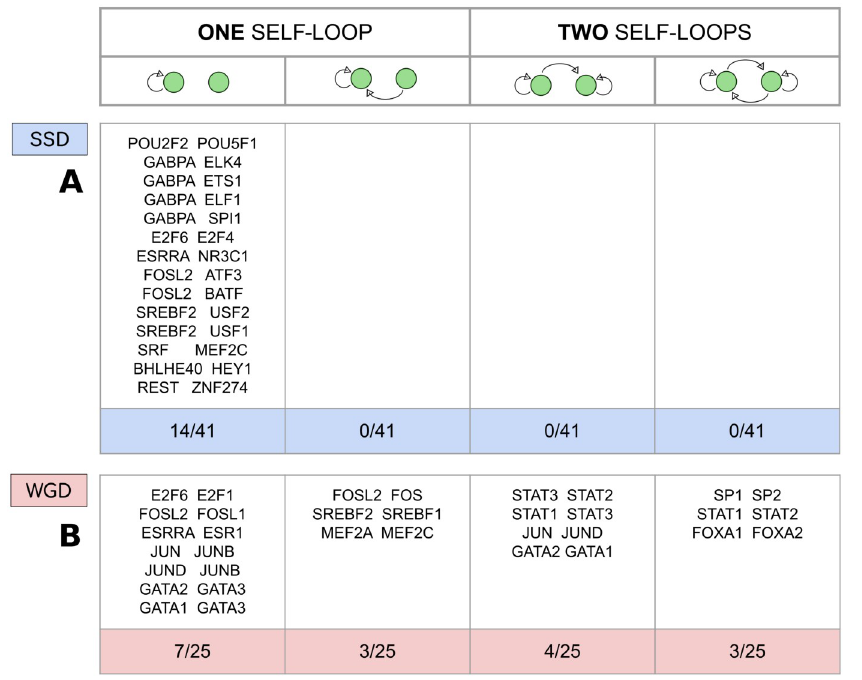
Fig 8. Feedback loops and self-loops in couples of duplicated transcription factors. (A) SSD and (B) WGD duplicate TF couples that contain at least one gene with a self-loop or that display a mutual regulatory interaction in the ENCODE regulatory network, subdivided by equal topological arrangements.